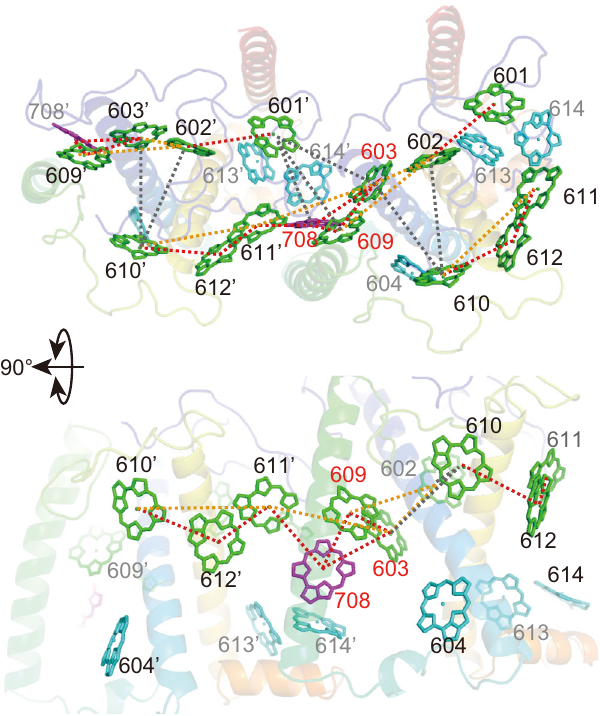
Fig.7|ThechlorophyllnetworkinPc-frLHC. Connectionsamongchlorophyll a in Pc-frLHC. Energetically connected stromal chlorophylls (including Chl708) are linkedbydottedlines(SupplementaryTable3).Thedottedlinesarecoloredbased on the values of exciton couplings ( EC cm − 1 unit): EC >60 in red, 60 ≥ EC >30 in orange,and30 ≥ EC >10ingray.Chlorophyllsonthestromalandlumenalsidesare shown in green and cyan, respectively. Chl708 is shown in purple. While Chls613 ’ and 614 ’ are energetically connected to Chls708, 612 ’ , and 601 ’ , for clarity they are shownonly partiallyinthis fi gure. Theupperpanelisviewed from the stromalside and the lower panel is viewed from outside the undecamer